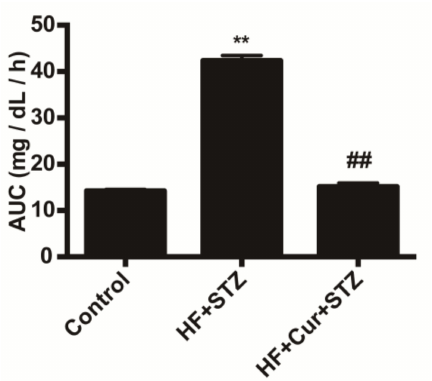
Figure 1. E ff ect of curcumin intervention on the area-under-the-curve (AUC) in rats fed a high-fat diet. HF + Cur + STZ: high-fat diet combined with curcumin and STZ group; HF + STZ: high-fat diet and streptozotocin group. The data are expressed as the mean ± SEM. ** p < 0.01, compared with the control group; ## p < 0.01, compared with the HF + STZ group; Control ( n = 6), HF + STZ ( n = 10), and HF + Cur + STZ ( n = 10).